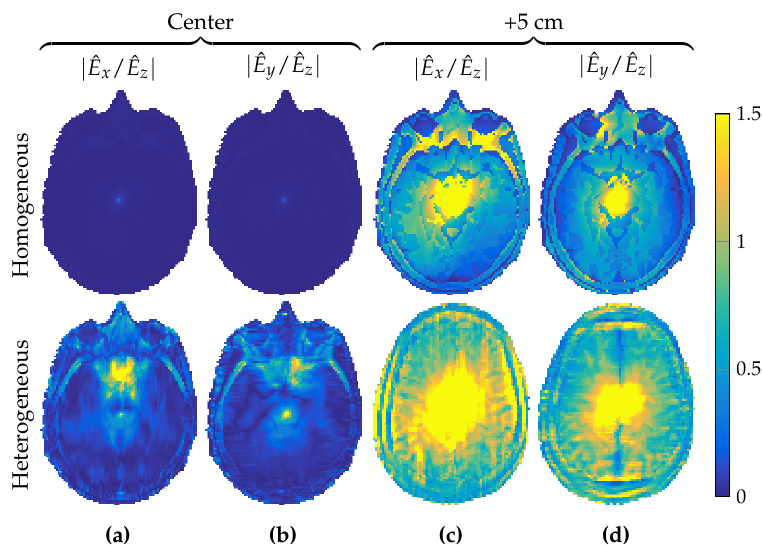
Figure 4. Ratios of x and y components of the electric-field strength relative to its z component. Relative field components at ( a , b ) the center slice and ( c , d ) the slice 5 cm higher. Top row is for the longitudinally uniform object, bottom row for the object with longitudinal